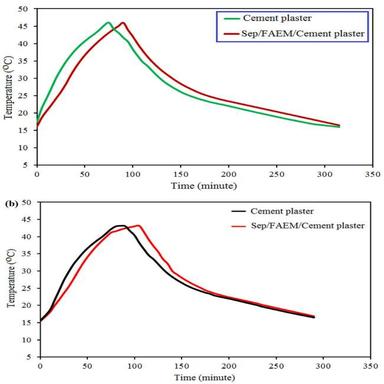
(a) Temperature variations at inner surface location of the cement plastered wall with/without Sep/FAEM composite. (b) Temperature variations at inner center location of the cement plastered room with/without Sep/FAEM composite.